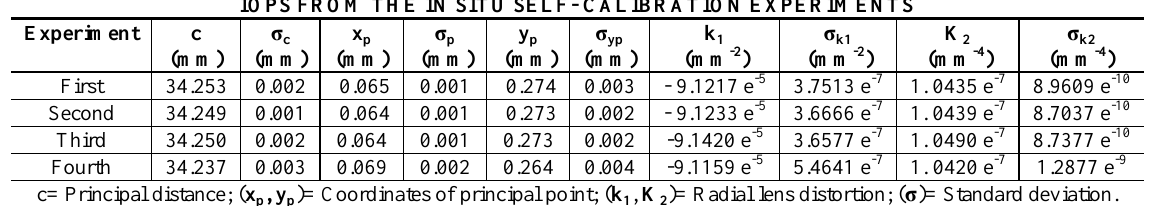
Table 2. The interior orientation parameters (IOP) estimated in experiments of the in situ self-calibration